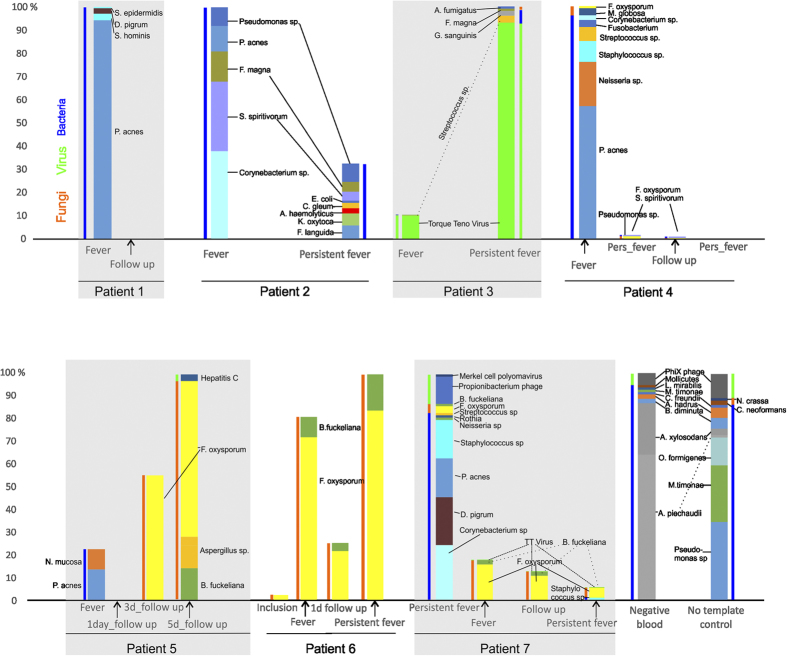
Relative abundances of bacterial, fungal and viral taxa are shown in individual samples.The highest bar for each patient represents the highest number of reads; the heights of other bars of the same patient are proportional to the highest. Wider bars represent taxa on the species level, slim bars show domains. Only taxa with ≥1% relative abundance are shown.